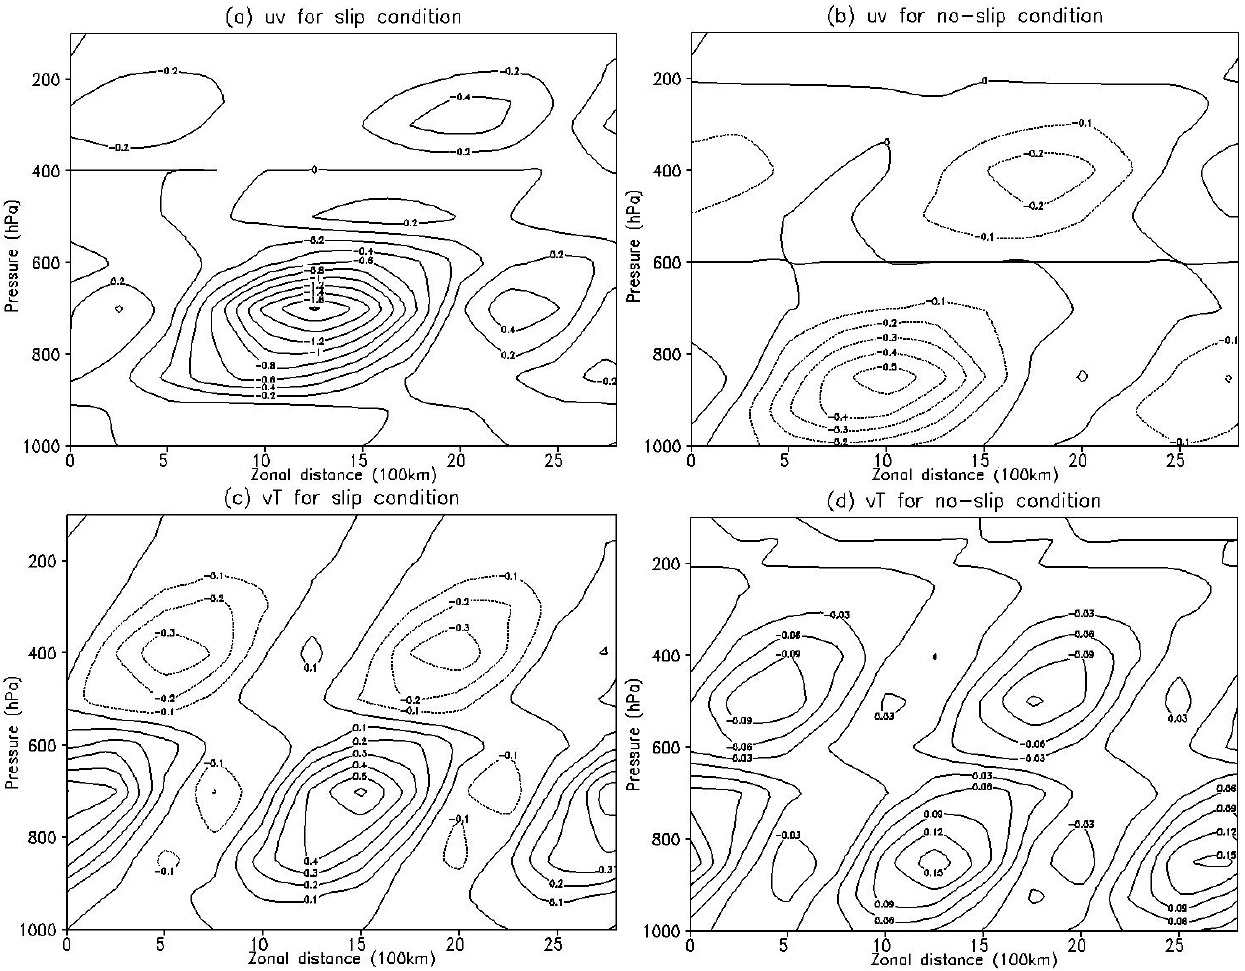
Fig. 6. Vertical cross section along 15 ◦ N of wave-wave components of northward fluxes of westerly momentum and temperature associate with the normal mode for (a) and (c) slip ( ε = 1) and (b) and (d) no-slip ( ε = 0) boundary condition. Contour intervals for easterly momentum − 2 − 2 flux are 0 . 2m 2 s in (a) and 0 . 1m 2 s in (b), and for meridional temperature flux are 0.1Kms − 1 in (c) and 0.03Kms − 1 in